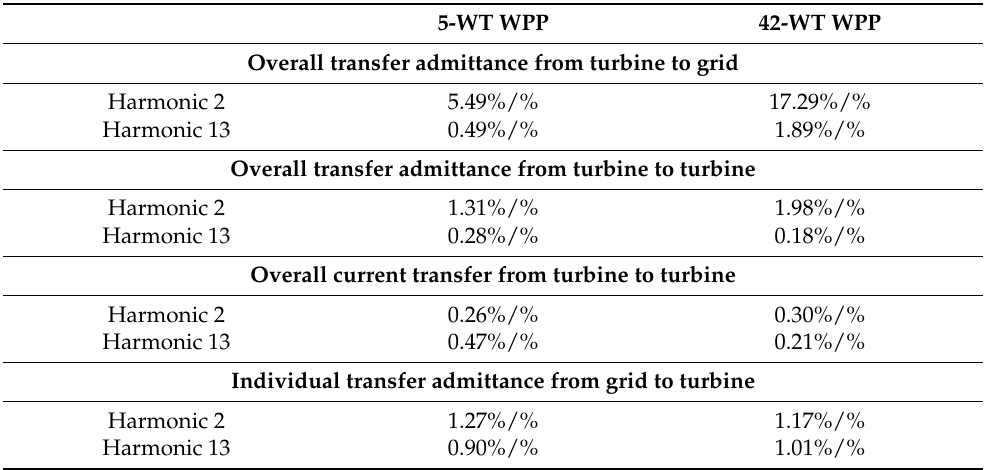
Table 2. Different transfer functions expressed in percentage of rated voltage or current. 5-WT WPP 42-WT